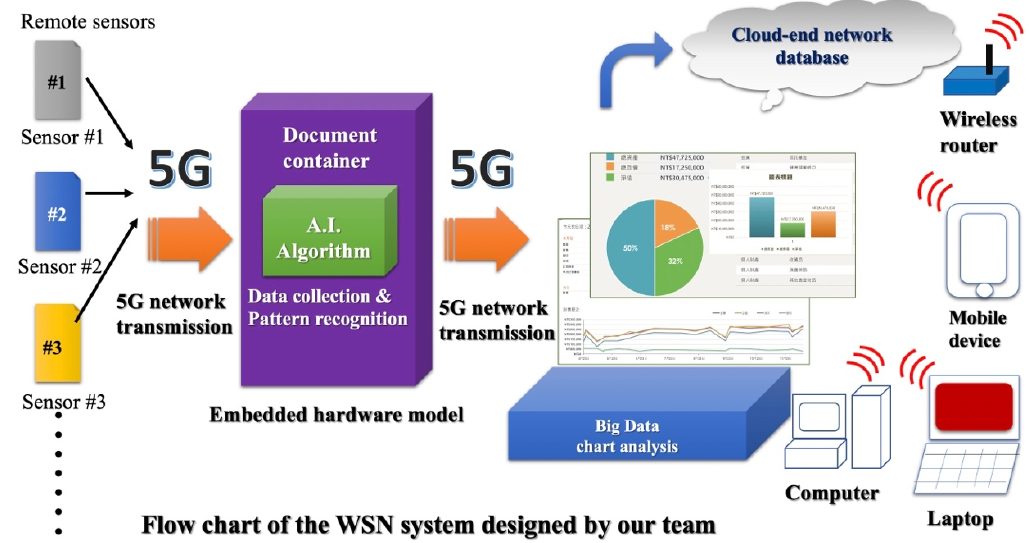
Figure 1. Wireless sensor networks using 5G communication transmission.